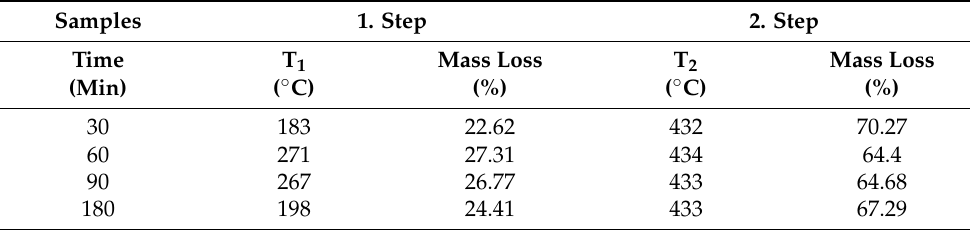
Figure 5. TGA ( a ) and DTGA ( b ) curves for samples obtained at different reaction times. Table 4. Main parameters obtained by thermogravimetric